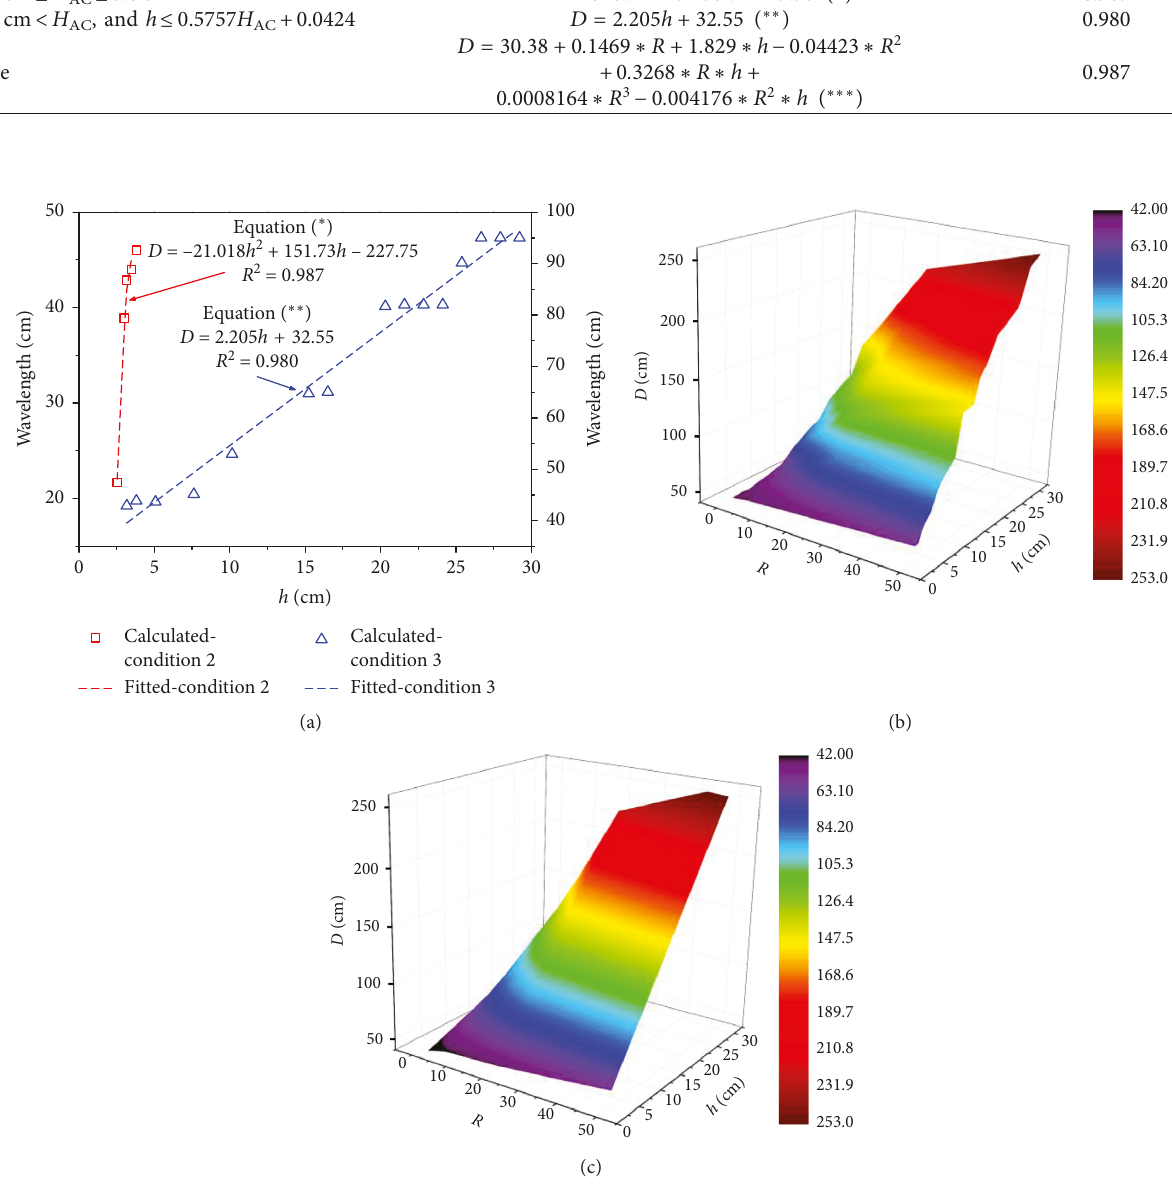
Figure 5: Wavelength under different combinations of R and h : (a) wavelength for equations ( ∗ ) and ( ∗∗ ); (b) calculated wavelength for equation ( ∗∗∗ ); (c) fitted wavelength by using equation ( ∗∗∗